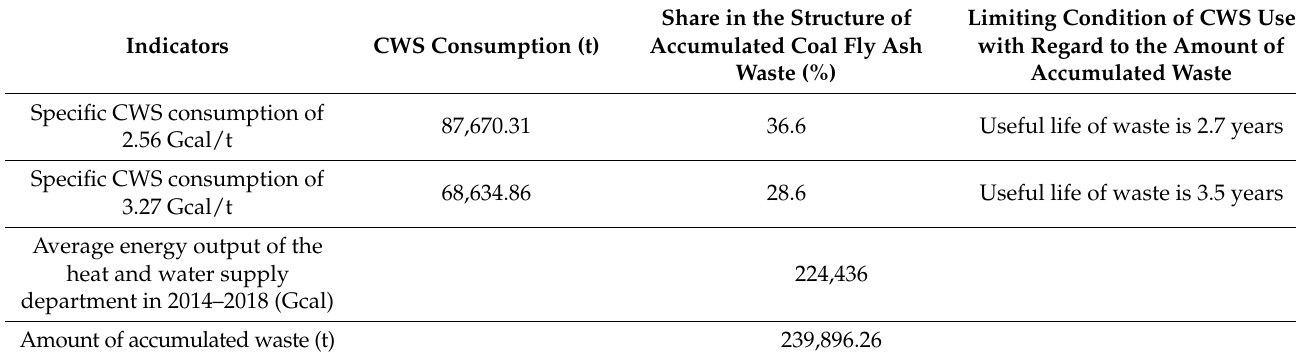
Table 2. Structure indicator of CWS volumes in dependence to specific consumption rates. Source: designed by authors using [64].